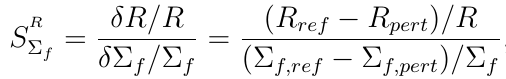
Table 4: Relative sensitivity coefficients for k , power in central assembly P peripheral assembly P with respect to Σ in the various groups adopted, estimated directly 5 f with